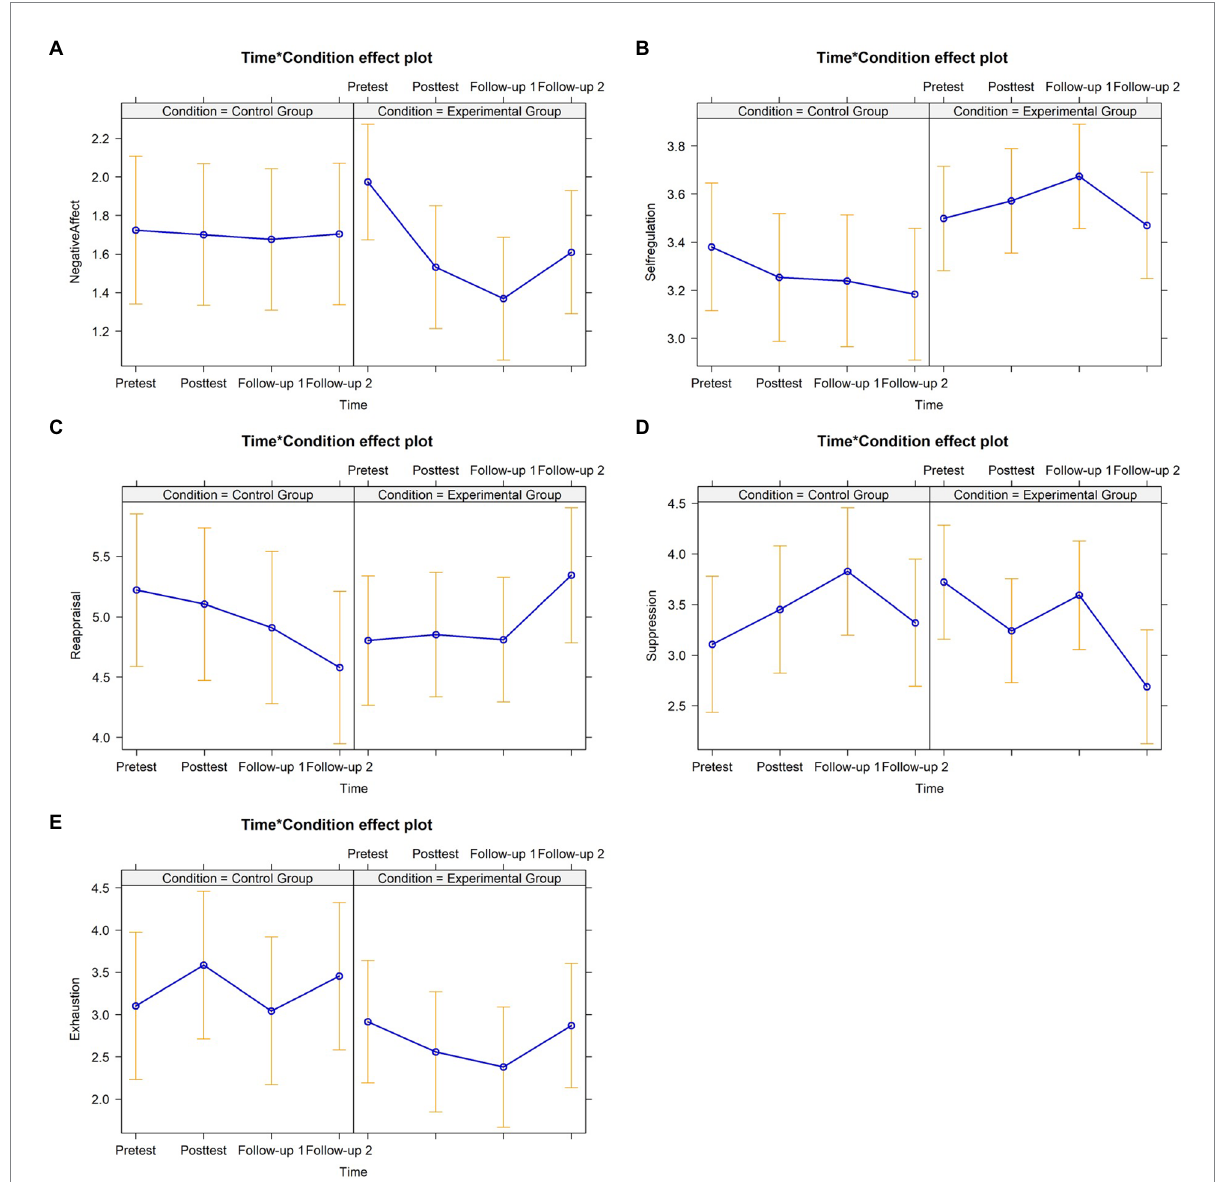
FIGURE 3 Graphical representation of interaction effects (Time*Treatment Condition) on proximal and distal dependent variables – Cluster A. (A) Negative affect depicting a significant effect at follow-up-1 ( B = − 0.56, SE = 0.26, 95% CI [ − 1.06, − 0.06], f 2 = − 0.91). (B) Self-regulation skills depicting a significant effect at follow-up-1 ( B = 0.32, SE = 0.14, 95% CI [0.04, 0.59], f 2 = 0.78). (C) Cognitive reappraisal depicting a significant effect at follow- up-2 ( B = 1.18, SE = 0.51, 95% CI [0.18, 2.18], f 2 = 1.38). (D) Expressive suppression depicting a significant effect at follow-up-2 ( B = − 1.25, SE = 0.61, 95% CI [ − 2.44, − 0.05], f 2 = − 1.38). (E) Emotional exhaustion symptoms depicting a significant effect at posttest ( B = − 0.84, SE = 0.40, 95% CI [ − 1.62, − 0.06], f 2 = −